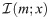
Comparison of PI in input gradient and output pattern.PI in m (solid) and σ (dashed) are shown for three different input noise levels ((A)-(C)) as a function of χ, parametrizing the gradient shape (cf. Fig 2A). The computation of I(m;x) is described in S3 Appendix.